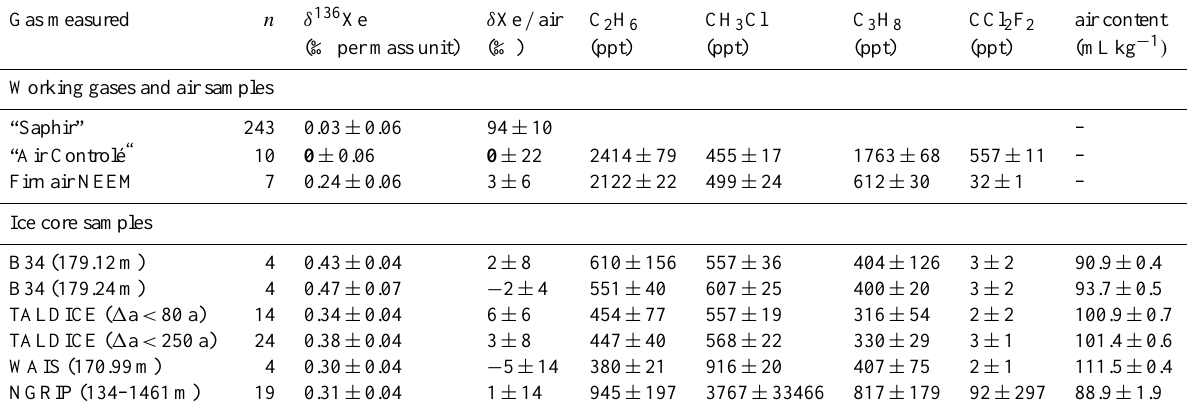
Table 5. Means and 1 σ standard deviations of isotope and mixing ratios of trace gases and air content extracted from ice samples. Assigned reference values are in bold. ”Boulder” is not listed here since its time series is used to calculate the calibration curves for the parameters. δ Xe / air is the anomaly of the atmospheric Xe mixing ratio with respect to the standard in ‰. Mixing ratios are not corrected for blank contribution. Note that CCl 2 F 2 is absent in the pre-industrial air, and the reported values for ice samples are contamination. See caption of Table 4 for further